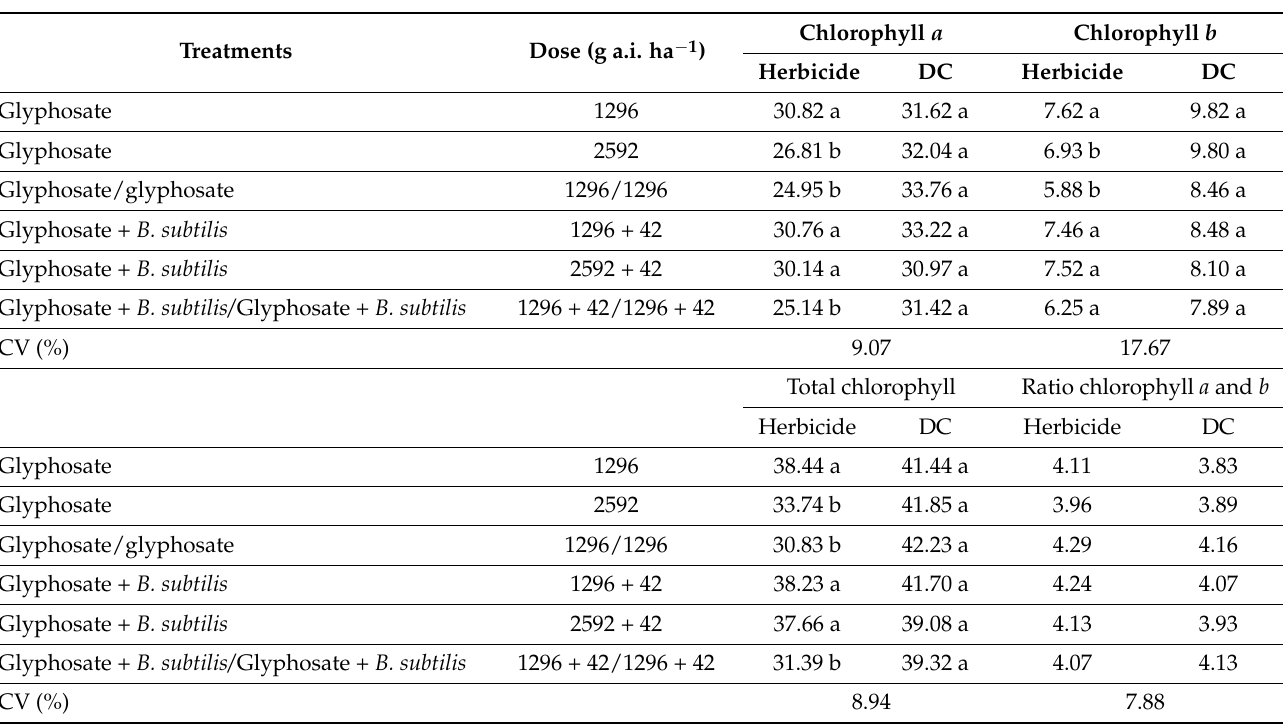
Table 3. Relative chlorophyll index in soybean plants submitted to post-emergence application of glyphosate at different doses and stages and association with B. subtilis